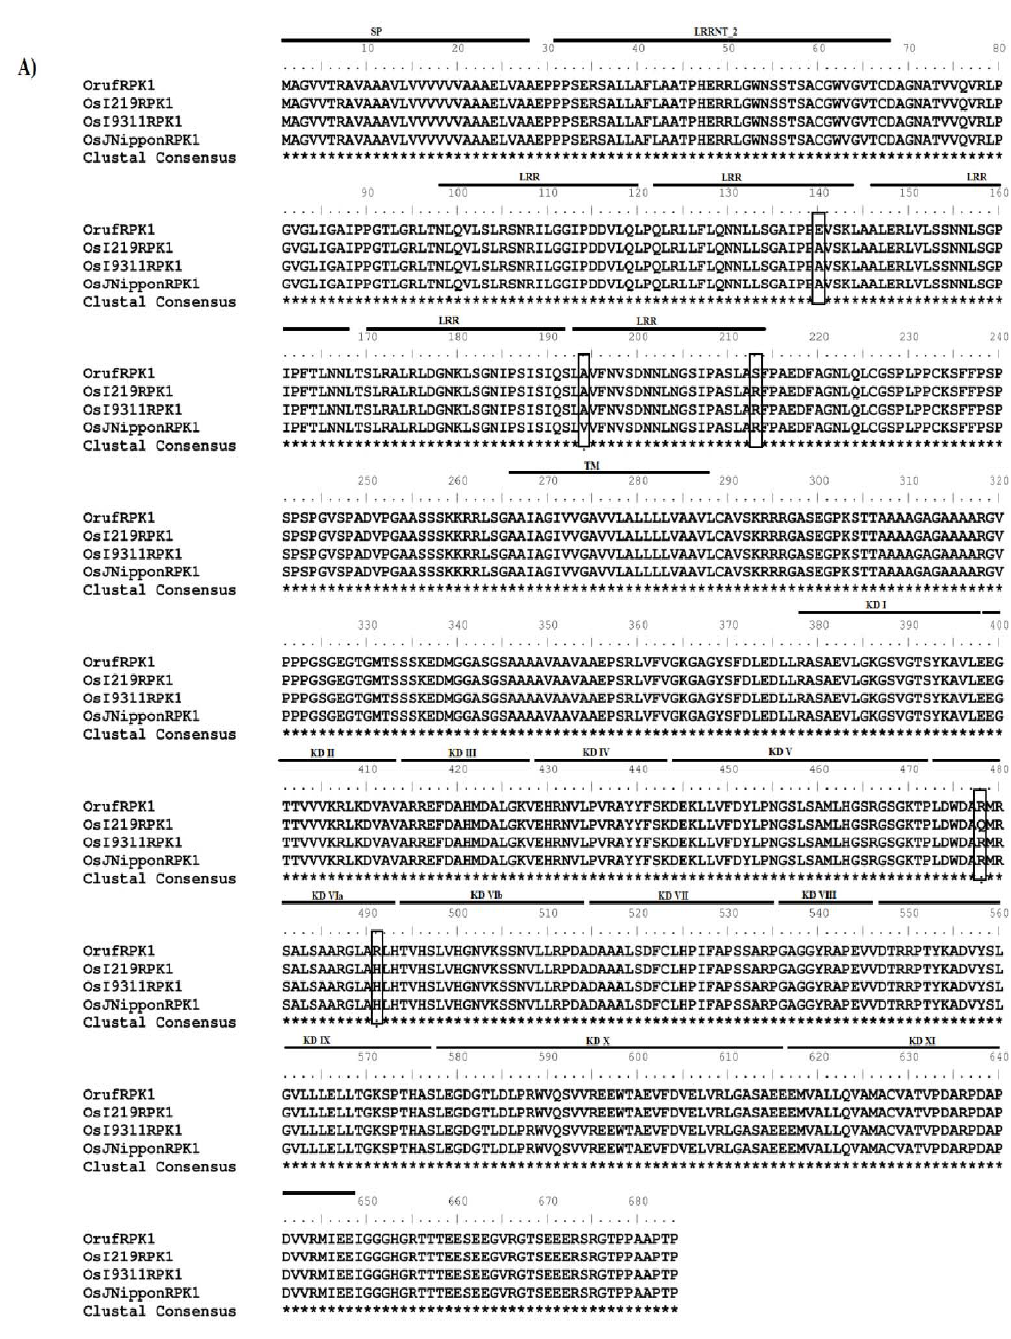
Figure 1. Comparison of OrufRPK1 with orthologous proteins. ( A ) Amino acid sequence alignment of OrufRPK1, OsI219RPK1, OsI9311RPK1 and OsJNipponRPK1. All five amino acid substitutions are vertically boxed. SP: signal peptide; LRR: leucine-rich